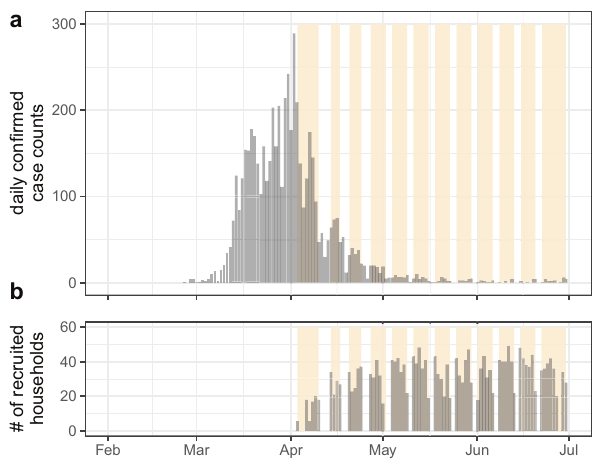
Fig. 1 Epidemic curve and recruitment period of household